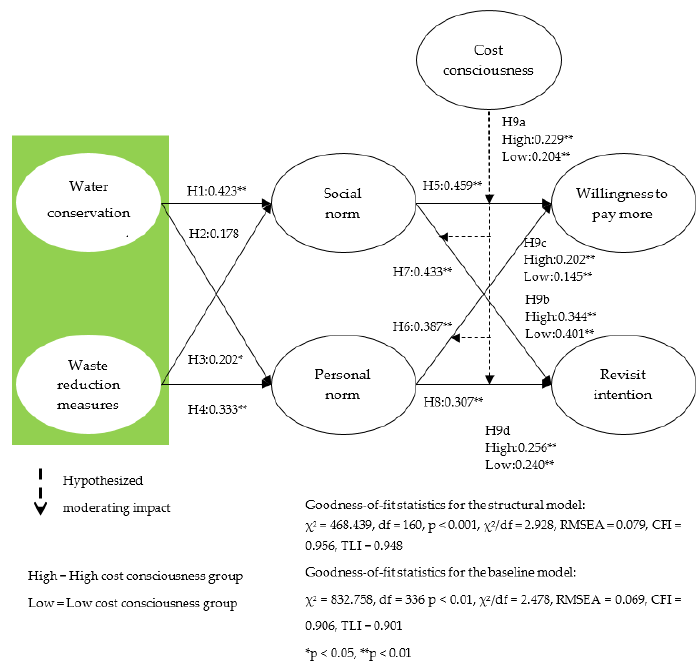
Figure 1. Structural model results and hypotheses testing. Table 2. Structure model results.